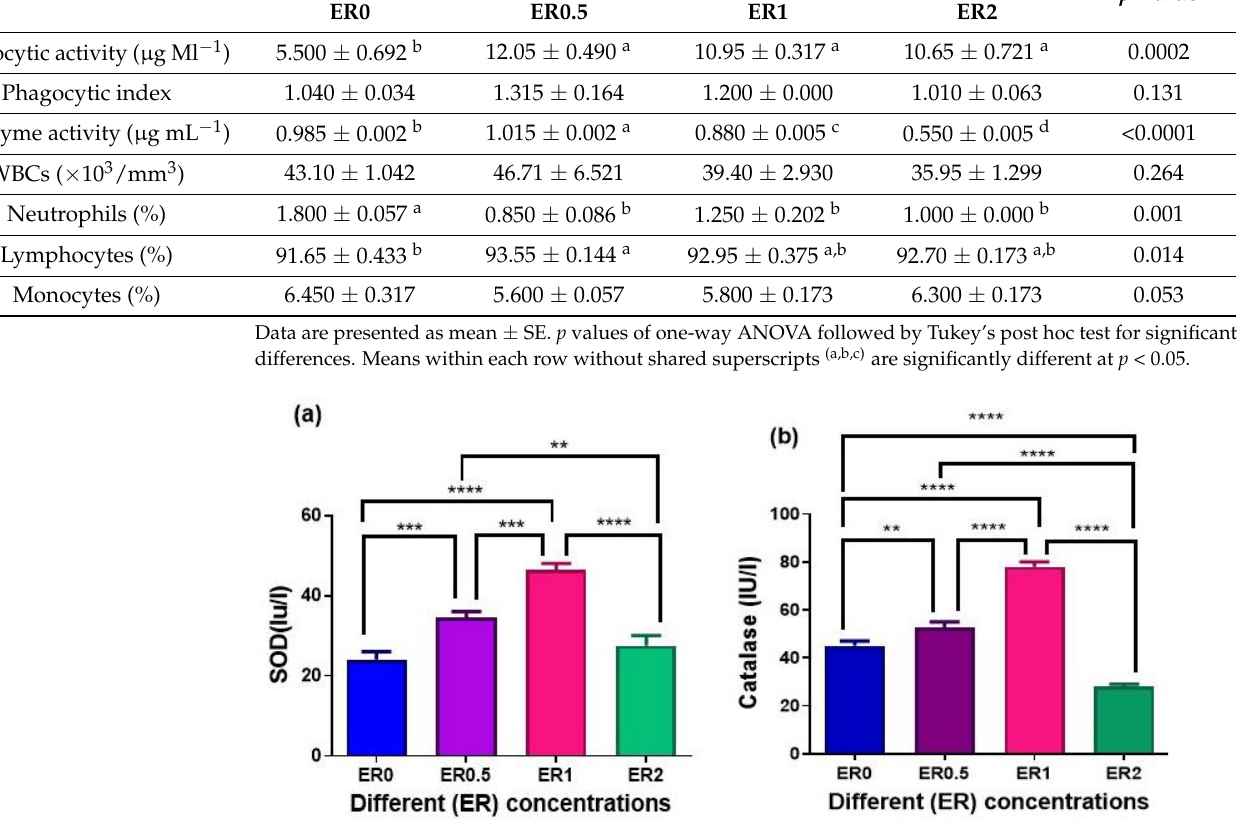
Figure 3. Antioxidant enzyme activity ( a ) SOD, and ( b ) catalase of red tilapia fed different dietary levels of ER. Values are expressed as mean ± SE from triplicate groups with p values of one-way ANOVA followed Tukey’s post hoc test for significant differences. p < 0.01 (**), p < 0.001 (***), and p < 0.0001 (****) between different groups.